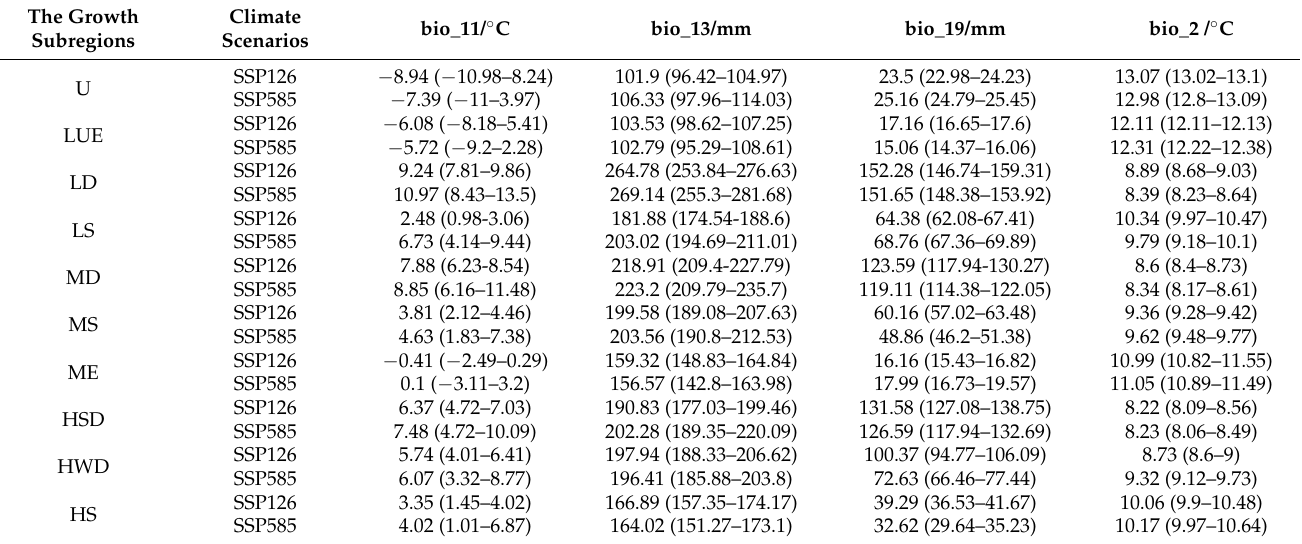
Table 7. The characteristics of dominant variables in growth subregions of C. bungei under SSP126 and SSP585. Internal and external values in parentheses mean, respectively, the range and mean value of variables during different periods in the growth